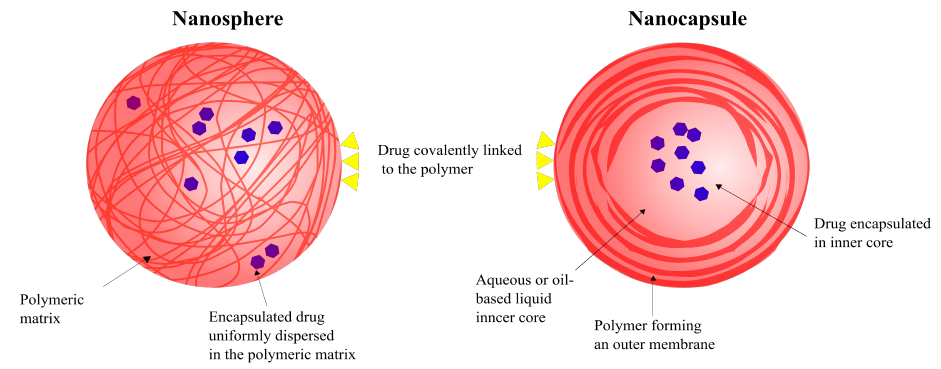
Figure 13. Schematic representation highlighting the differences between the two types of solid polymeric nanoparticles, nanospheres and